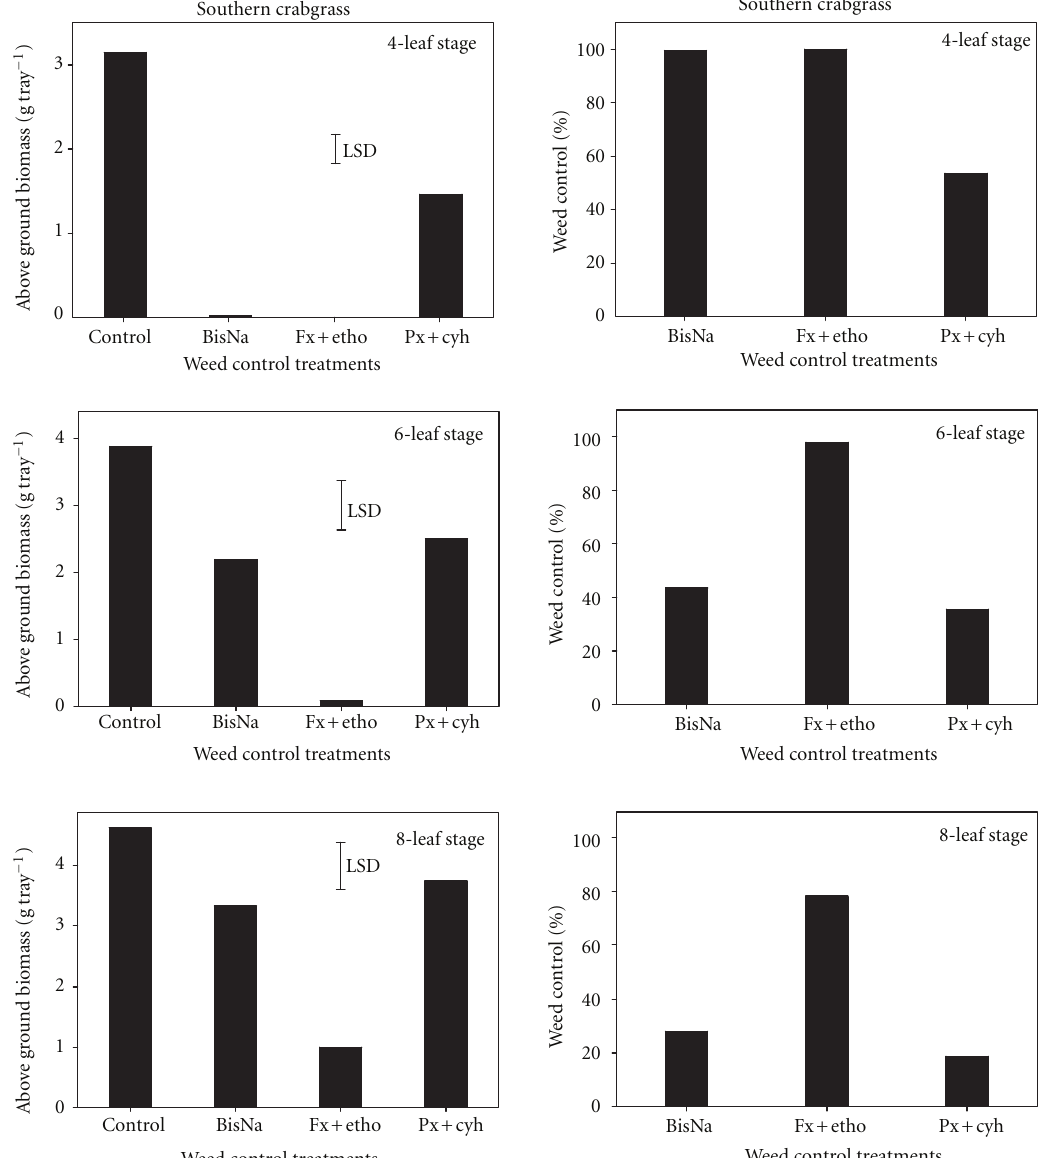
Figure 4: E ff ect of postemergence herbicides (BisNa, bispyribac-sodium; Fx+etho, fenoxaprop-p-ethyl + ethoxysulfuron; Px+cyh, penox- sulam + cyhalofop) on aboveground dry biomass (g) and control (%) of southern crabgrass when sprayed at its four-, six-, and eight-leaf stages. Mean comparisons were performed based on least significant di ff erence test at